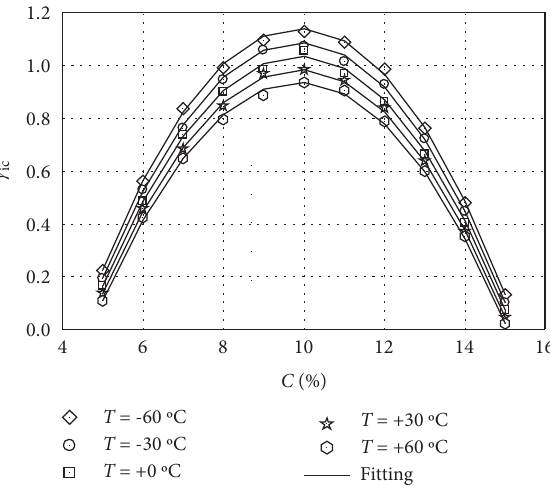
Figure 8: Relation among c